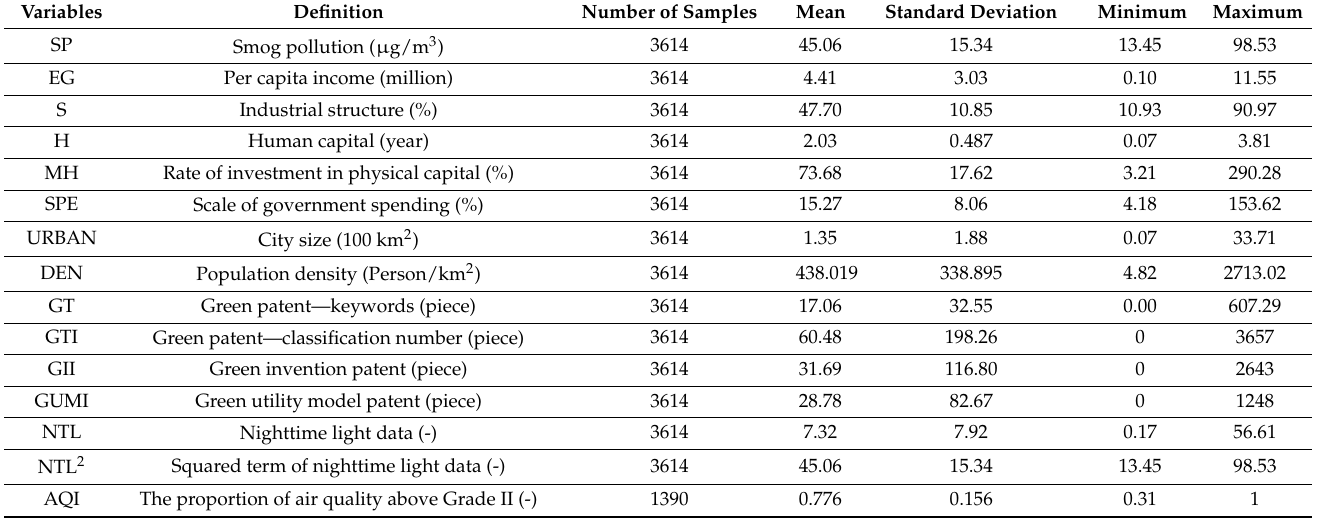
Table 3. Granger causality test results of the